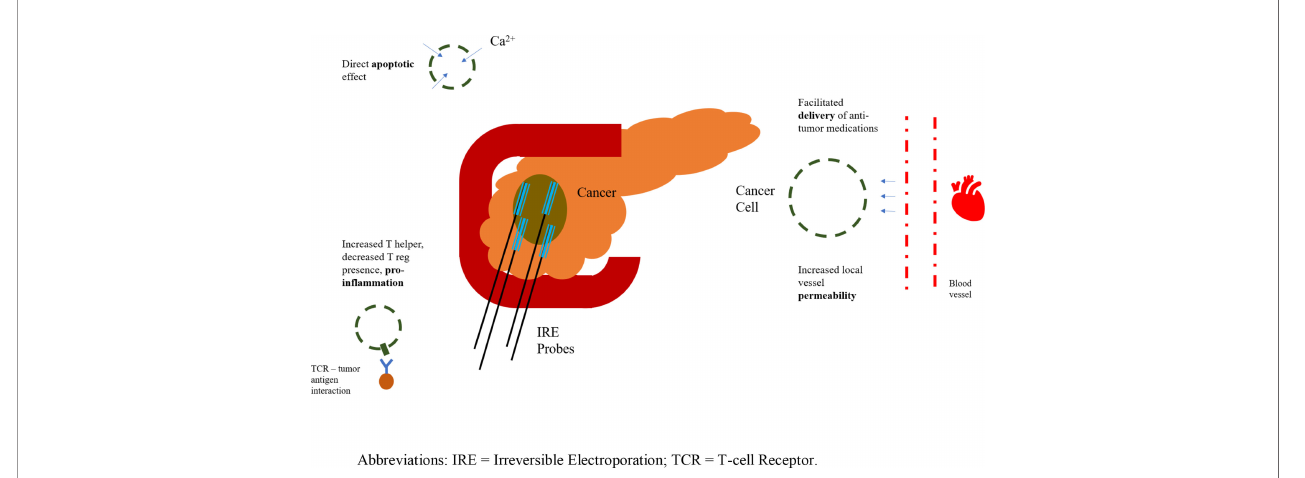
FIGURE 2 | Irreversible electroporation application; representation of probes and anti-tumor effects. IRE, Irreversible Electroporation; TCR, T-cell